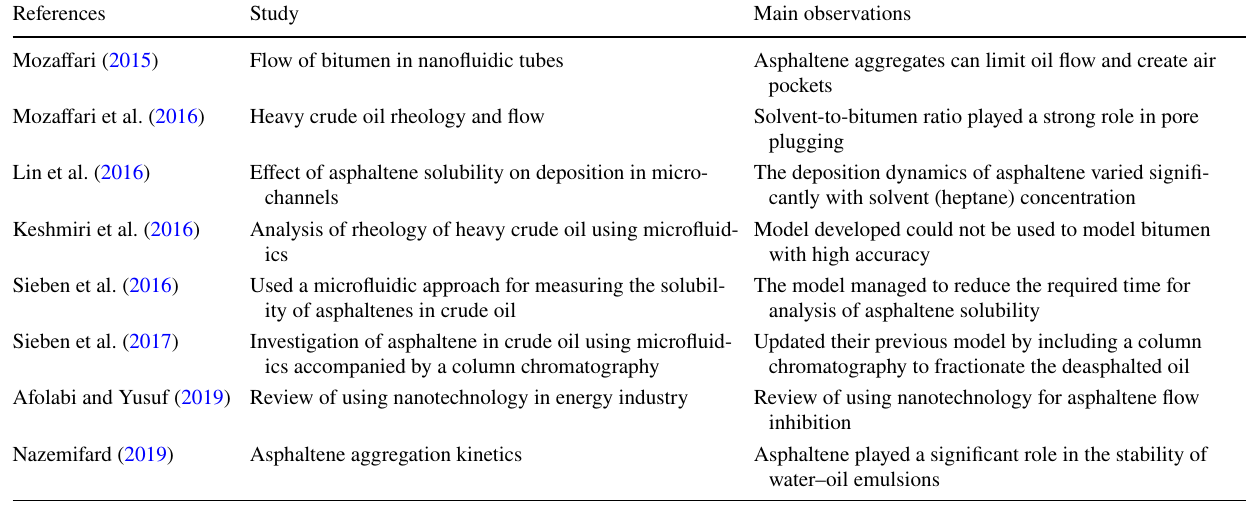
Table 3 Summary of micro- and nanofluidic studies involving